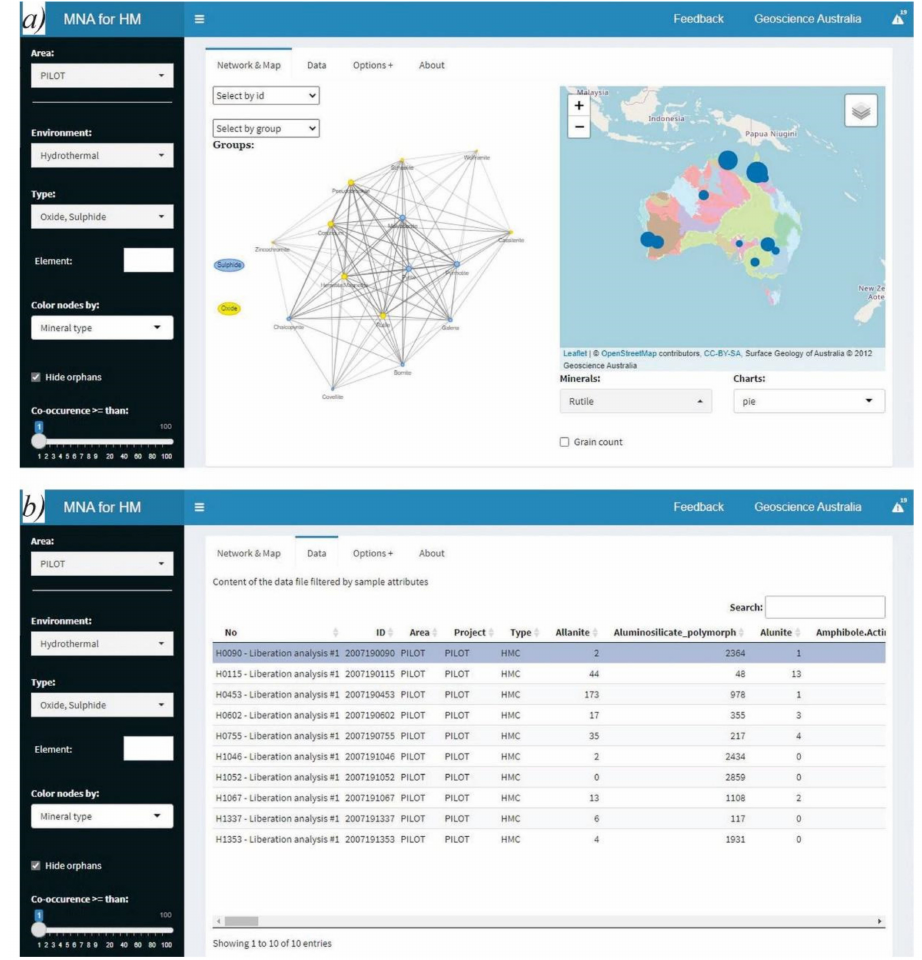
Figure 5. Graphical user interface for the Geoscience Australia MNA cloud-based visualization tool for the pilot project (https://geoscienceaustralia.shinyapps.io/mna4hm, accessed on 28 July 2022) showing the Network & Map ( a ), and the Data ( b )